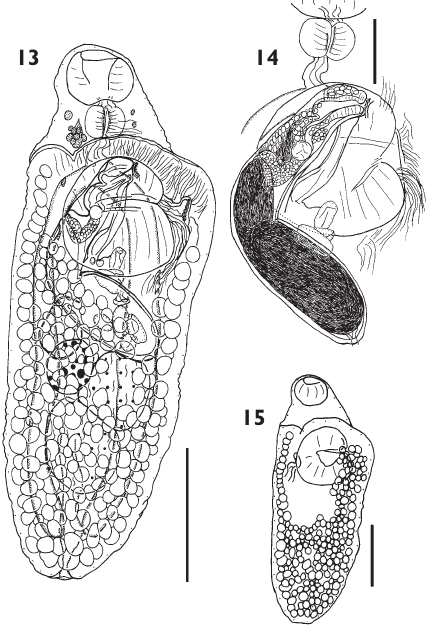
Figs 10-12. Macvicaria mutovitellina n. sp. ex Dactylophora nigricans . 10. Whole-mount ventral view. 11. Terminal genitalia. 12. Dorsal distribu- tion of vitelline follicles. Scale bars : 10, 12, 250